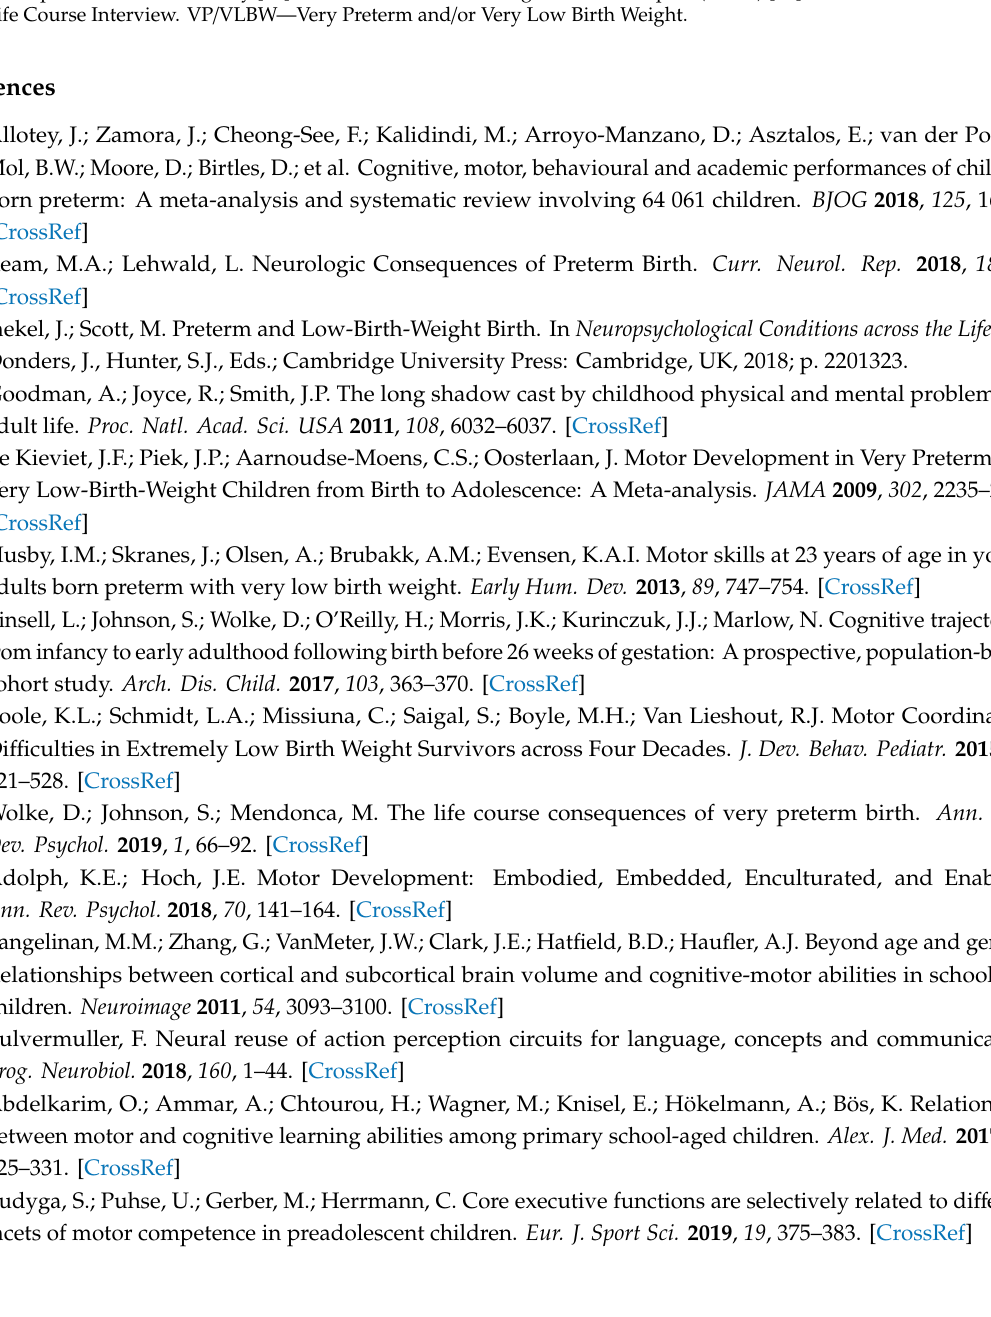
Low self-esteem regarding sports ( < 2 SD, standardised on controls)